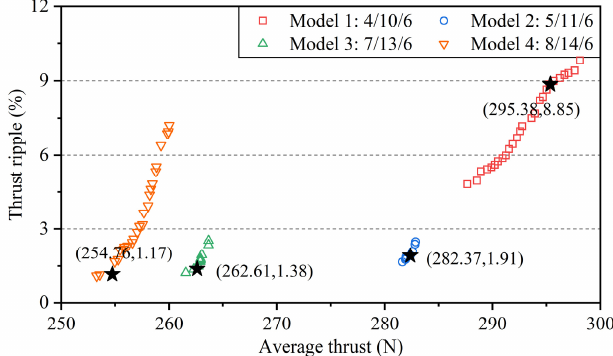
Figure 3. Multi ‐ objective optimization of DCB ‐ VRLMs using NSGA ‐ II algorithm.